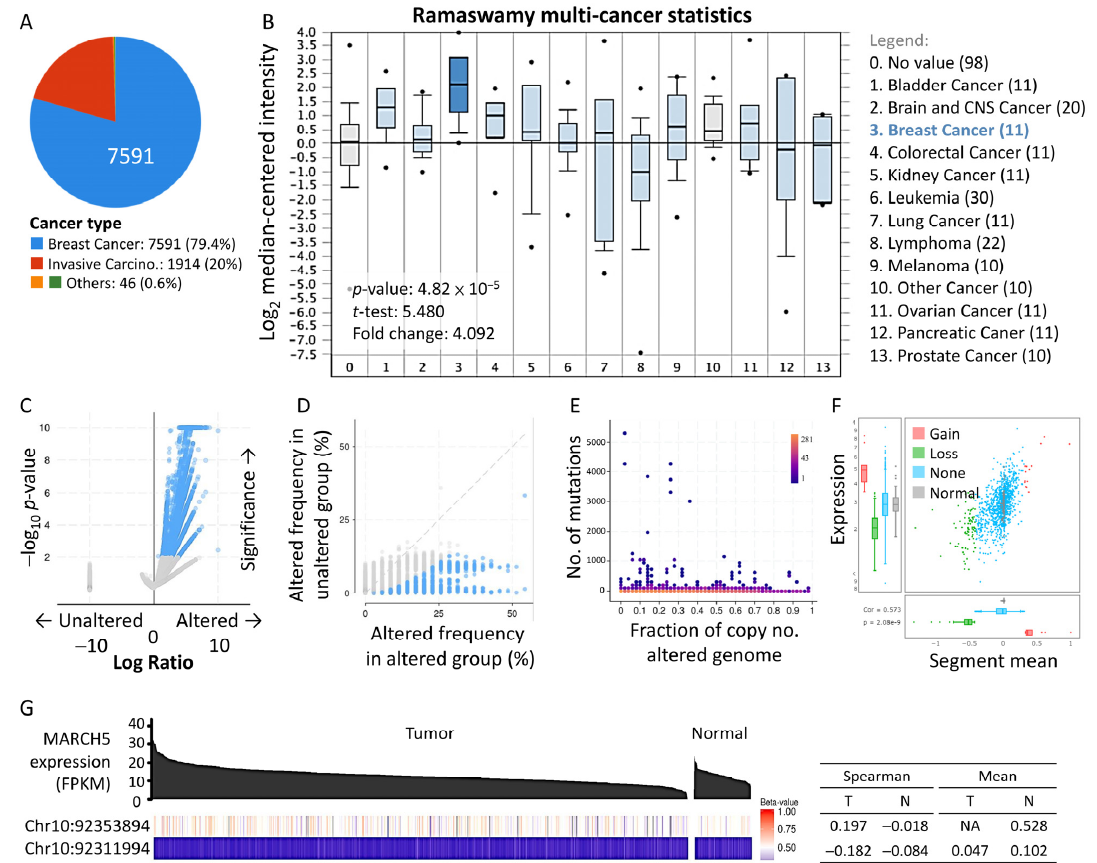
Figure 1. Functional enrichment analysis of MARCH5 in BRCA demographics and clinical events. ( A ) Circle graphs show percentage of cancer type in the study. ( B ) Oncomine database analysis of the expression of MARCH5 in different types of cancer. ( C,D ) Volcano and scatter plots exhibiting genes associated with mutations altered frequency in MARCH5 . ( E ) Proportion graph indicates the ratio of mutation counts and the range of changes in the number of genome alters. ( F ) A combination of scatter plots and box plots to show a more detailed view of the distribution and correlation of CNVs in breast cancer types. ( G ) Relationship between MARCH 5 and two different datasets from LinkedOmics (http://linkedomics.org/login.php, accessed on 24 August 2021). Red lines represent a positive correlation, and blue lines represent a negative correlation.